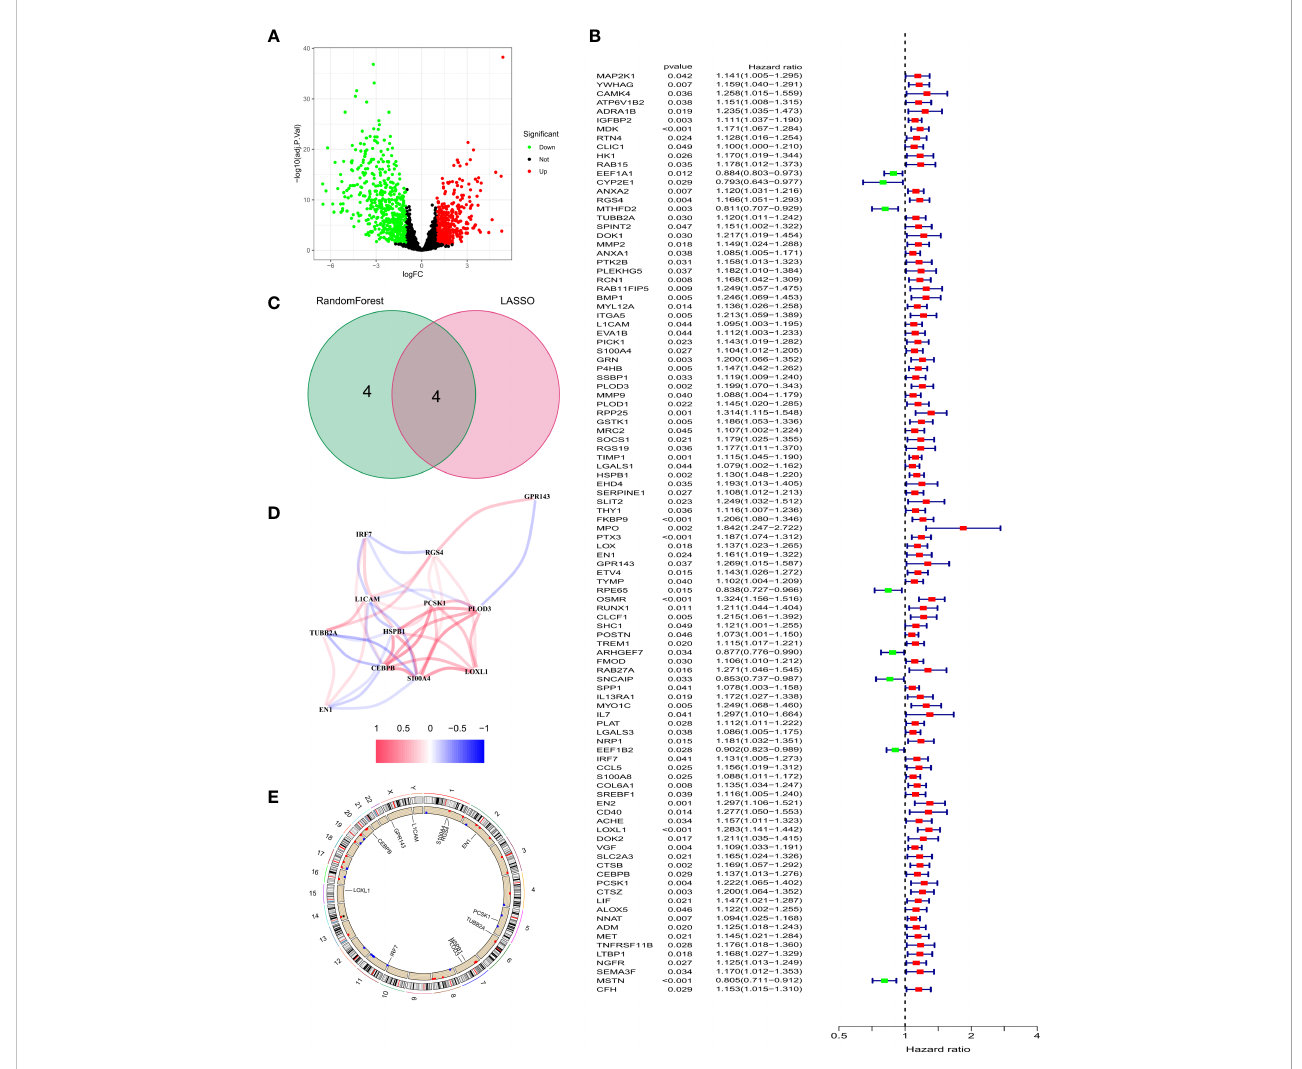
FIGURE 3 Identi fi cation of prognosis-related NFRGs in GBM patients in the TCGA cohort. (A) Volcano plot of DEGs. (B) Forest plot of univariate cox analysis. (C) The intersection of DEGs and univariate cox results for the GEO cohort. (D) Correlation analysis of 12 NFRGs. (E) Chromosomal localization of 12